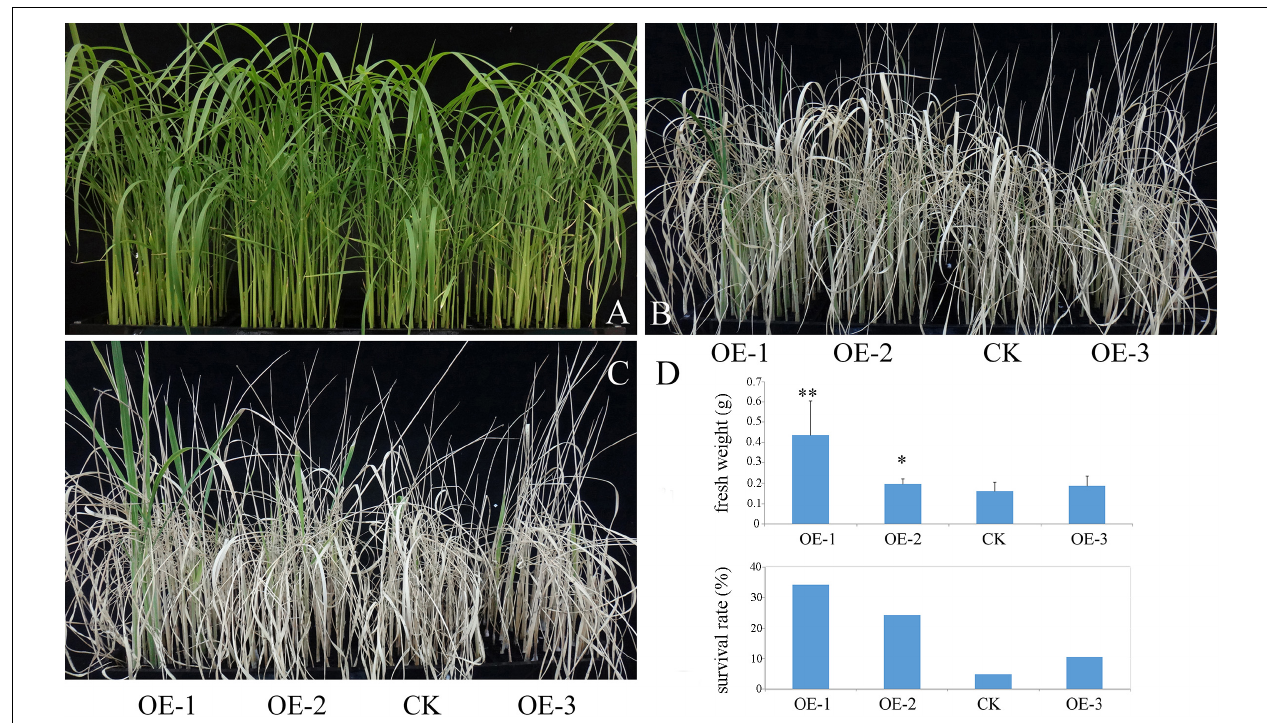
FIGURE 4 | Ectopic expression of PpBURP2 enhanced the tolerance of rice to salinity stress. PpBURP2 transgenic rice plants and WT plants were cultured in 96-well plates and treated with 150 mM NaCl for 10 days. Representative images of the WT and transgenic seedlings before (A) , during (B) , and after which they recovered for 5 days (C) . (D) Fresh weight and survival rate of PpBURP2 transgenic plants and WT plants after PEG-simulated osmotic stress. ∗ p < 0.05 and ∗∗ p <